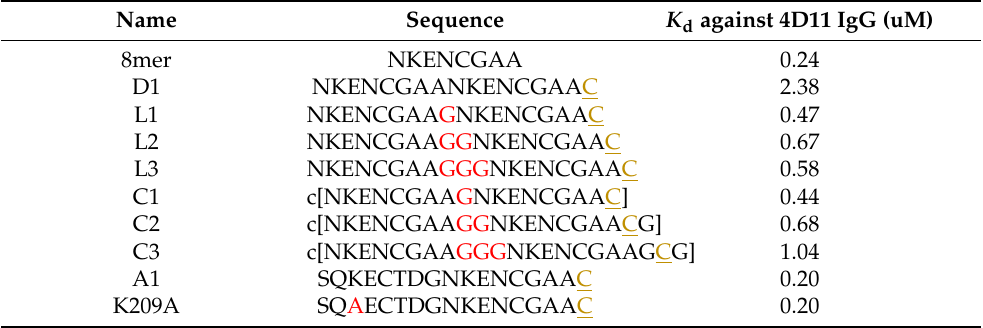
Table 2. Binding affinities of peptides for KLH conjugation were determined by a SPR competition binding assay. Cysteines required for conjugation to maleimide-activated KLH are indicated in yellow and underlined; additional linker residues and mutations are shown in red.